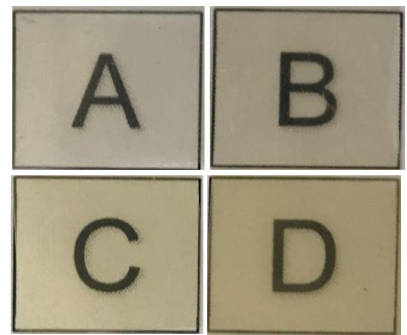
Figure 3. Visual aspect of the electrospun films of: ( A ) Neat poly(3-hydroxybutyrate- co -3-hydroxyvalerate) (PHBV); ( B ) Oregano essential oil (OEO)-containing PHBV; ( C ) Rosemary extract (RE)-containing PHBV; ( D ) Green tea tree extract (GTE)-containing PHBV. Films are 1.5 × 1.5 cm 2 . Table 2. Color parameters ( ∆ E *, a *, b *, and L *) and transparency characteristics of the electrospun films of poly(3-hydroxybutyrate- co -3-hydroxyvalerate) (PHBV) containing oregano essential oil (OEO), rosemary extract (RE), and green tea tree extract (GTE). Samples a* b* L*